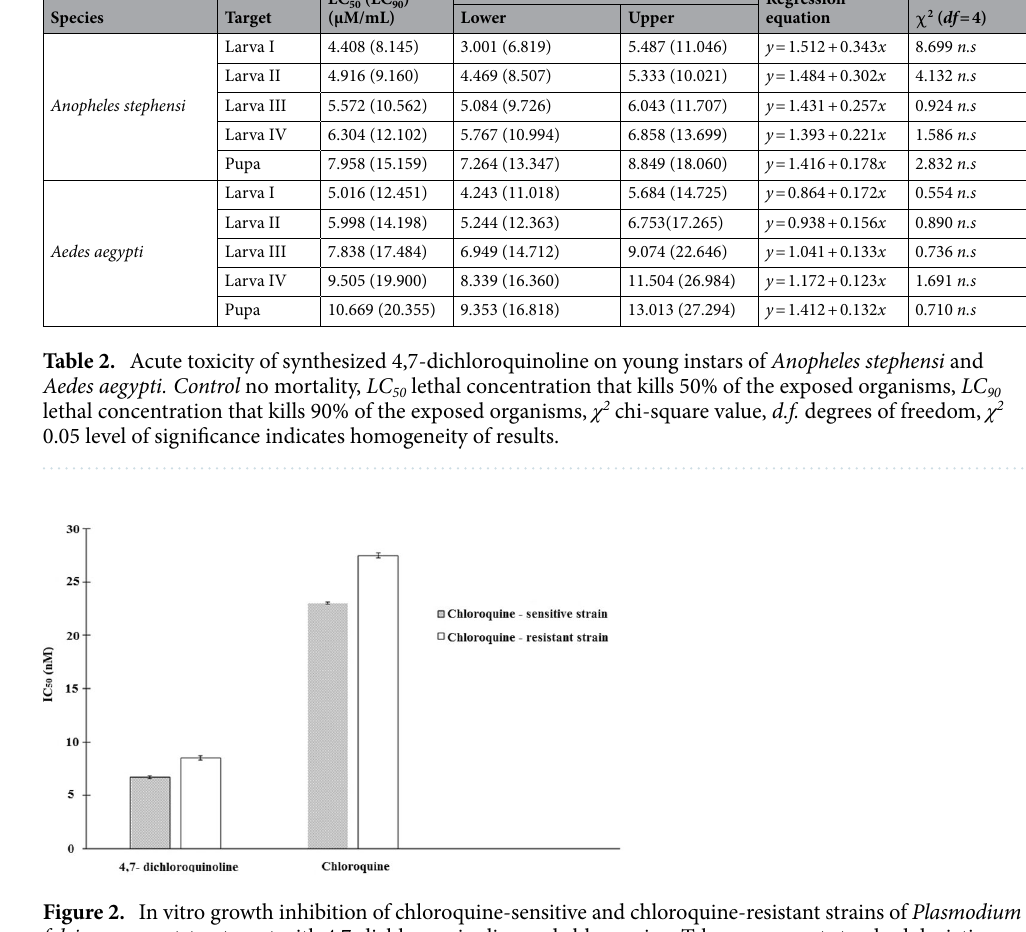
Figure 2. In vitro growth inhibition of chloroquine-sensitive and chloroquine-resistant strains of Plasmodium falciparum post-treatment with 4,7-dichloroquinoline and chloroquine. T-bars represent standard